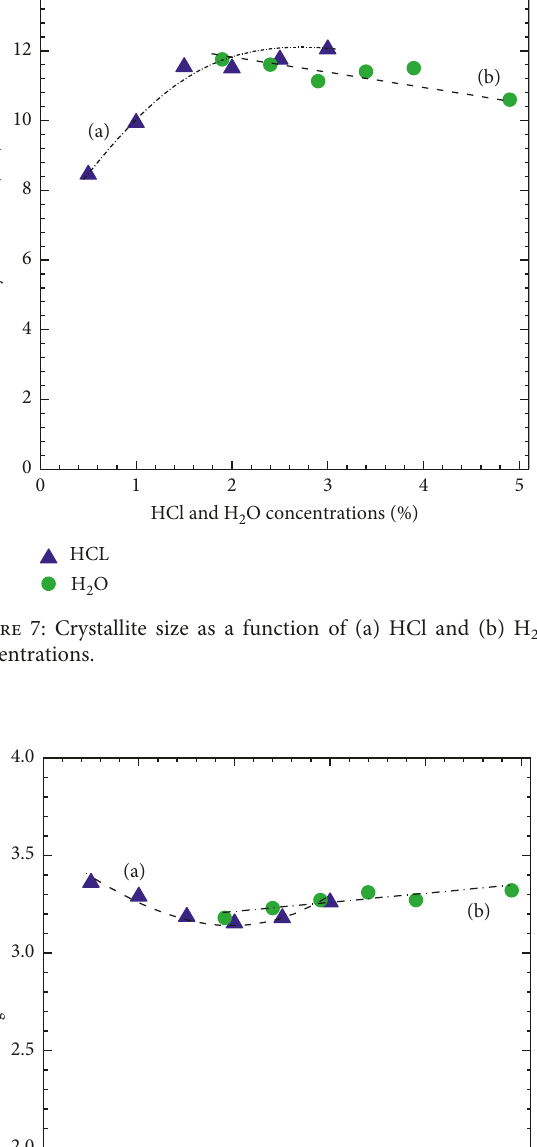
Figure 8: Band gap behavior of TiO 2m as a function of the (a) HCl and (b) H 2 O concentrations after thermal treatment in air at 530 °